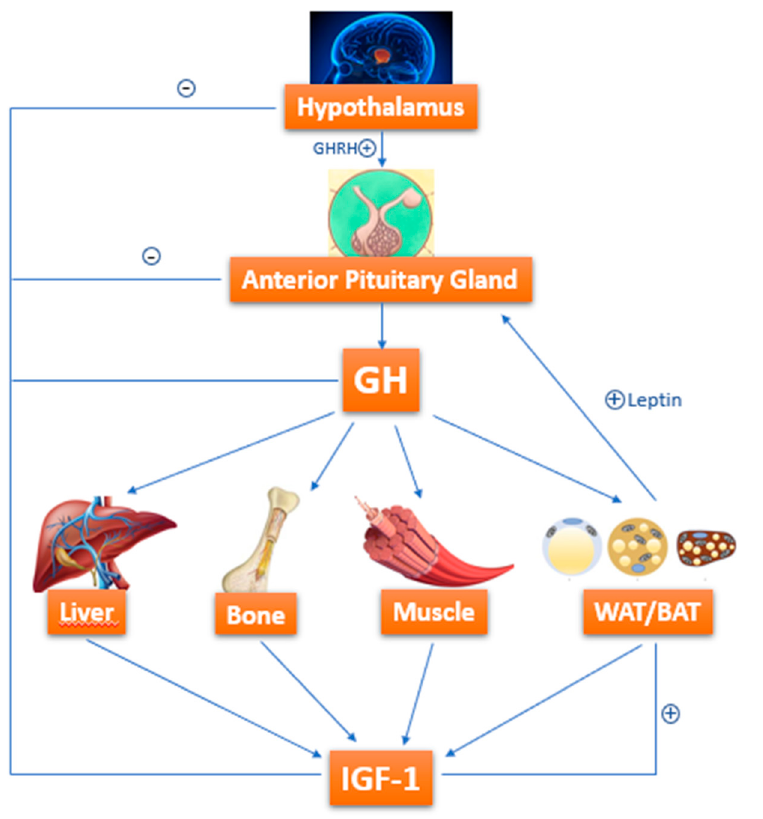
Figure 2. GH-IGF-1 axis: how growth hormone (GH) acts on target organs / tissues, leading to Insulin like Growth Factor-1 (IGF-1) production.